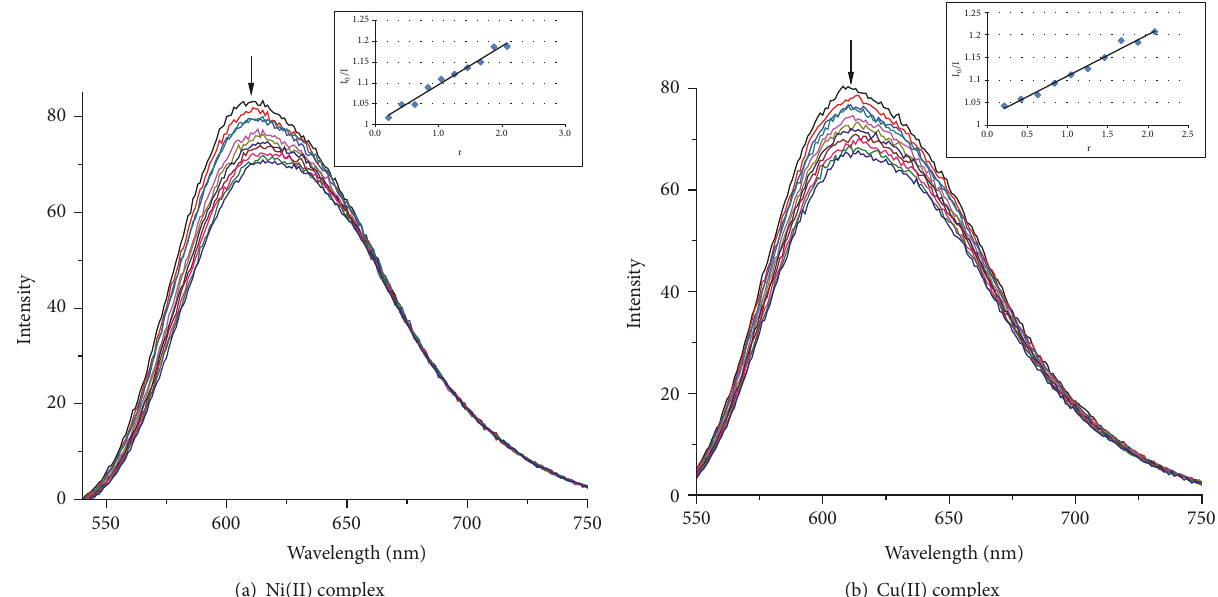
Figure 4: Emission spectra of EB–DNA, with increasing amounts (0-400 𝜇 L) of Ni(II) and Cu(II) complexes, [complex]=50 𝜇 M, [DNA]=20 𝜇 M (inset: Stern–Volmer quenching curves).